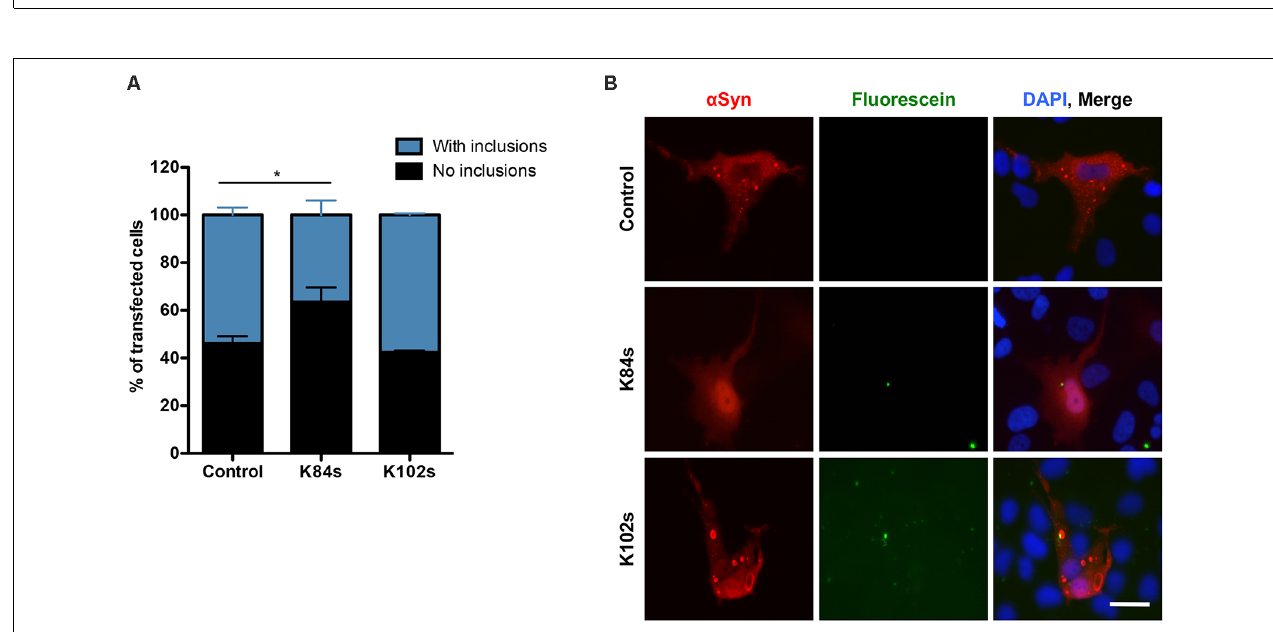
FIGURE 8 | K84s reduces α Syn aggregation in human cells. (A) H4 cells were transfected with α Syn and treated with K84s (1 µ M) or K102s (1 µ M). Control: 2% ethanol (vehicle). Significance of differences was calculated with one-side t -test (* p < 0.05; n = 3). (B) Representative images of transfected cells treated with 1 µ M of K84s and K102s. Scale bar = 30 µ